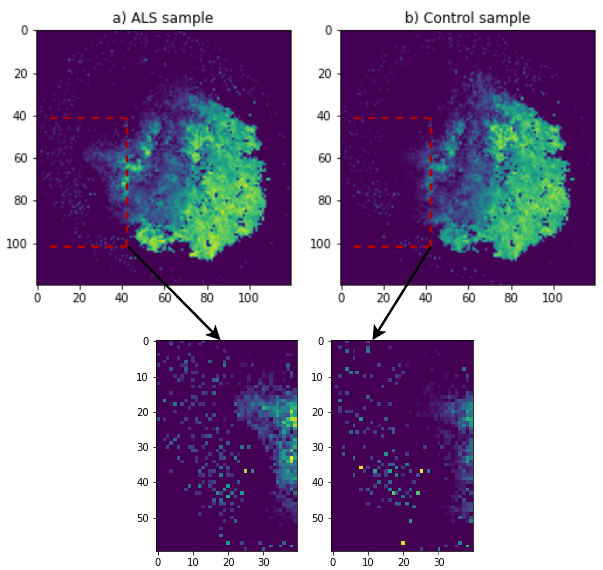
Figure 1. ALS and control sample images with 120 × 120 resolution obtained using DeepInsight for demonstration